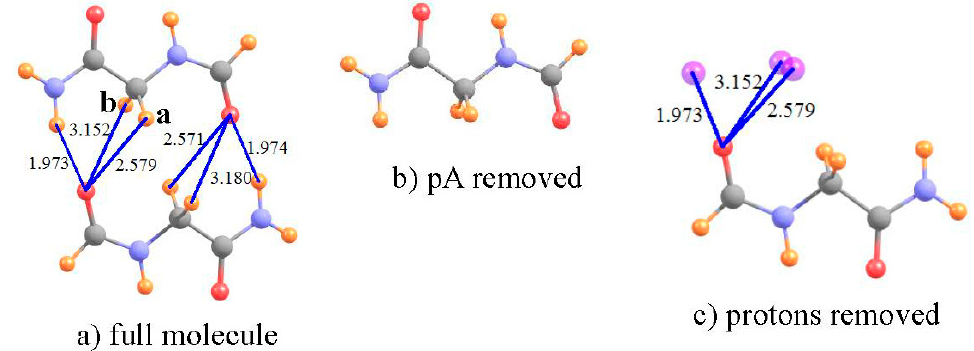
Figure 4. ( a ) Optimized NH 2 COCH 2 NHCHO dimer as model of segments of adjacent strands of antiparallel β -sheet. The lower dipeptide is removed in ( b ); and the upper deleted in ( c ). Purple spheres indicate locations of NH and CH protons from upper dipeptide. Distances are in Å. Table 3. NMR isotropic shielding (ppm) of models of the β -sheet structure in proteins shown in Figure 4, along with density at bond critical points ( ρ BCP ) in 10 − 3 au.